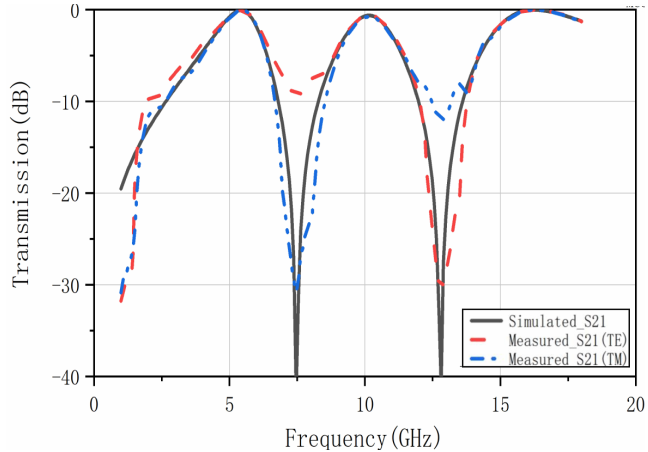
Figure 11. Comparison of transmission coefficient results between full-wave simulation and mea- surement